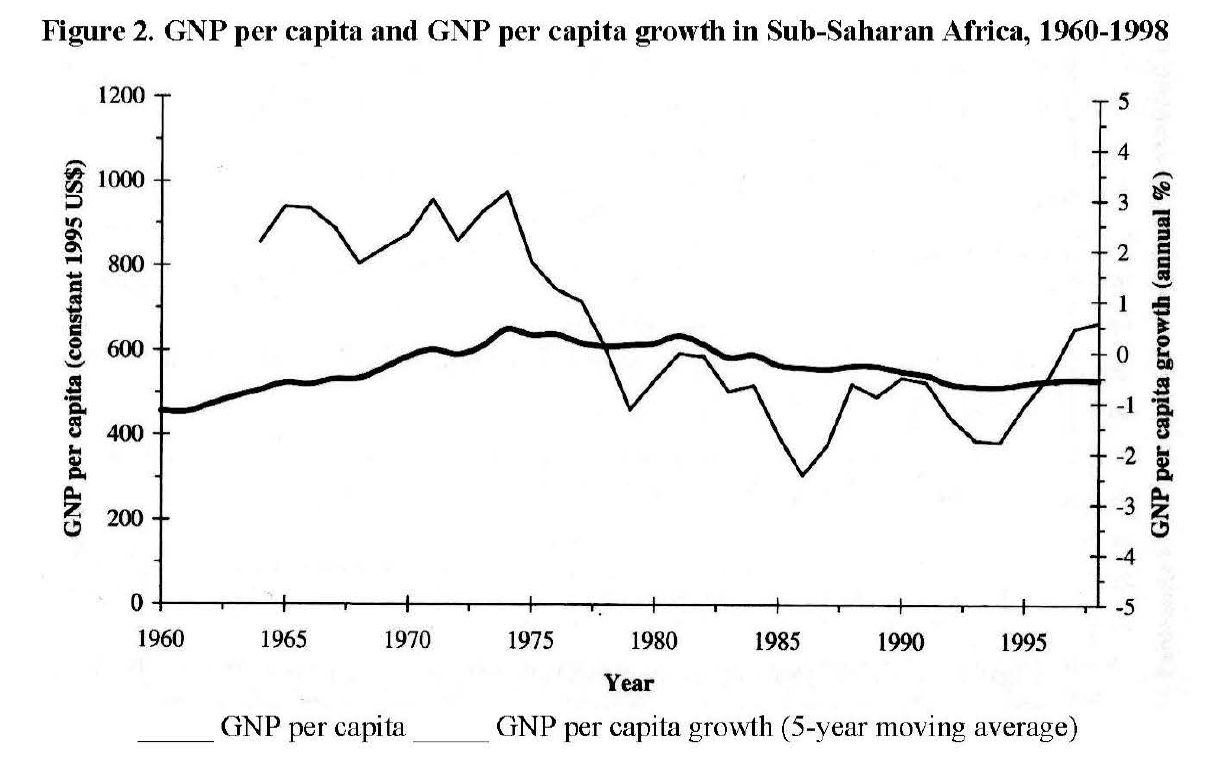
Figure 2. GNP per capita and GNP per capi ta growth in Sub-Saharan Africa,